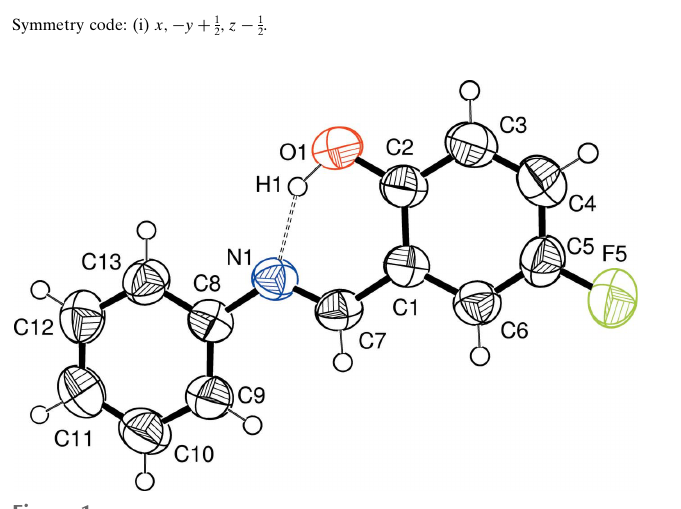
Figure 1 A view of the title compound, with displacement ellipsoids drawn at the 50% probability level. Dashed lines indicate the intramolecular hydrogen bond.